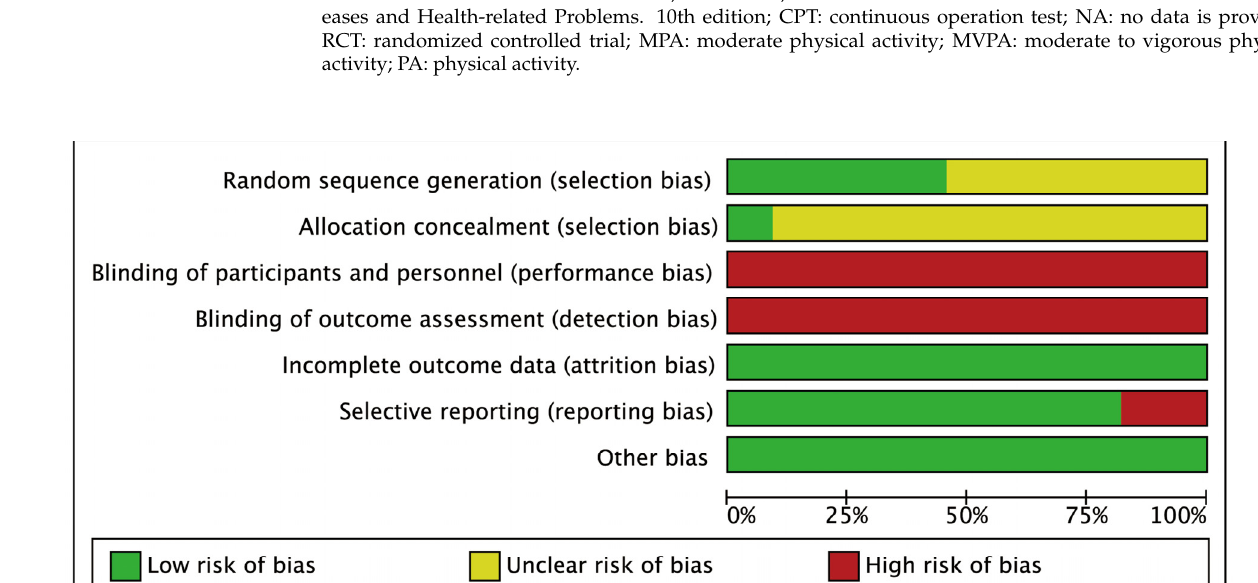
Figure 3. Forest plot of meta-analysis of PA on inhibition [29,38,42–50]. To explore whether heterogeneity among the studies was owing to a single study, a sensitivity analysis was carried out by eliminating them one at a time. The result showed that SMD ranges from 0.66–0.85, and the range of I 2 is 60–76%, respectively ( p < 0.05 each), indicating low sensitivity of data and certain stability and reliability of the results. To further explore the source of potential heterogeneity, subgroup analysis of poten- tial moderators was conducted (Table 2).